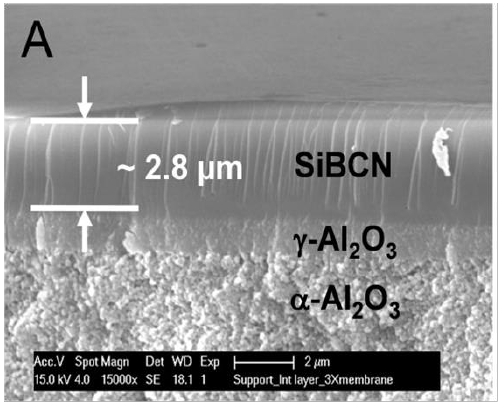
Figure 20. Cross section of a multilayered a-SiBCN/γ-Al 2 O 3 /α-Al 2 O 3 membrane (reprinted with permission from reference [394]; Copyright 2010